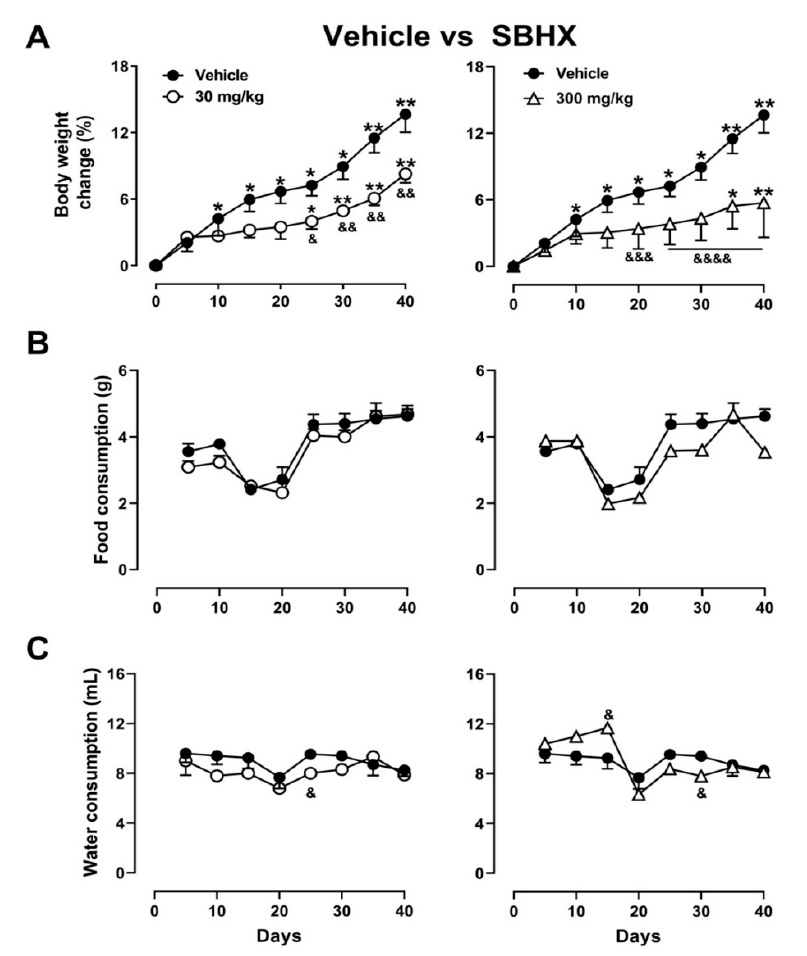
icant decrease in weight was observed without alteration in food (Figure 2B) and water (Figure 2C) consumption in both the 30 and 300 mg/kg SBHX groups in comparison to the vehicle group.